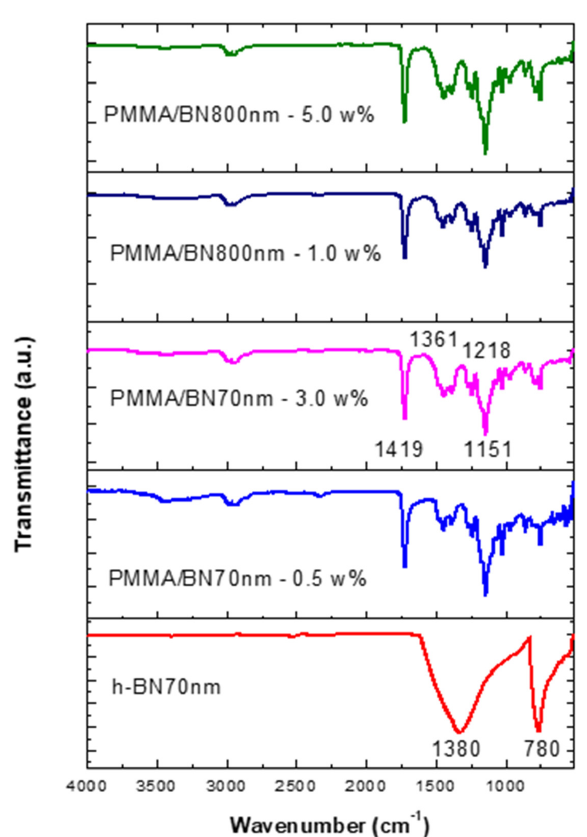
Figure 7. FTIR data of specimens made by ultrasonic mixing for nano-sized h-BN reinforcement with different concentrations.